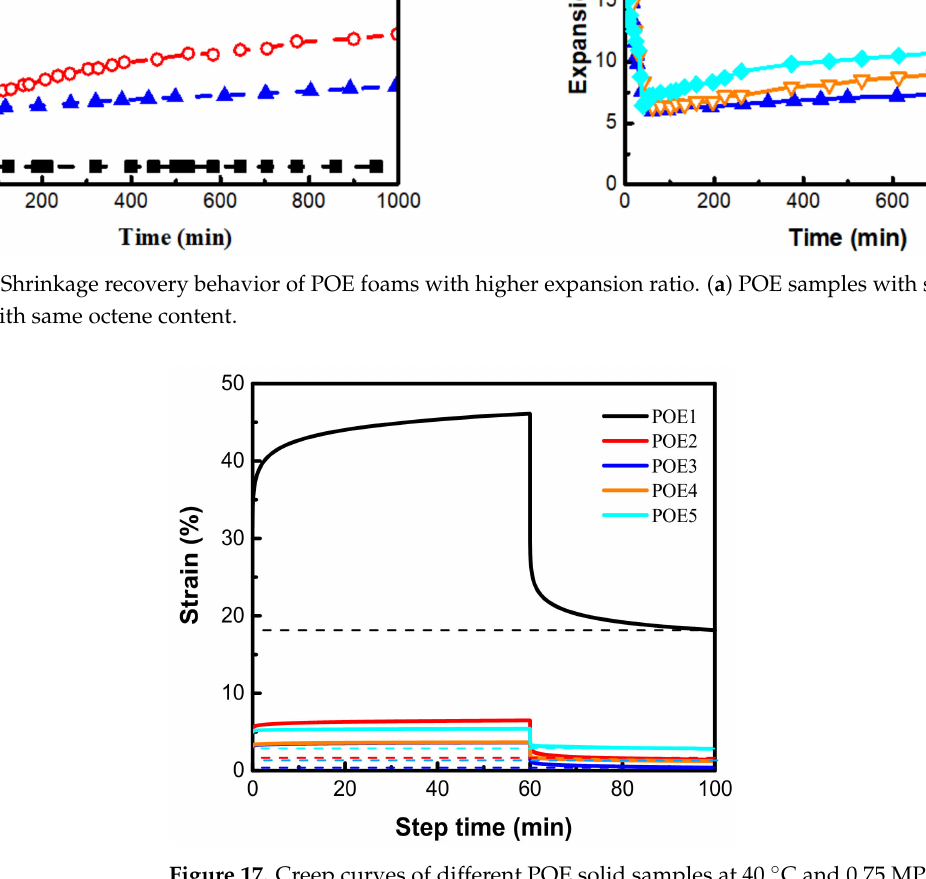
Figure 17. Creep curves of different POE solid samples at 40 ◦ C and 0.75